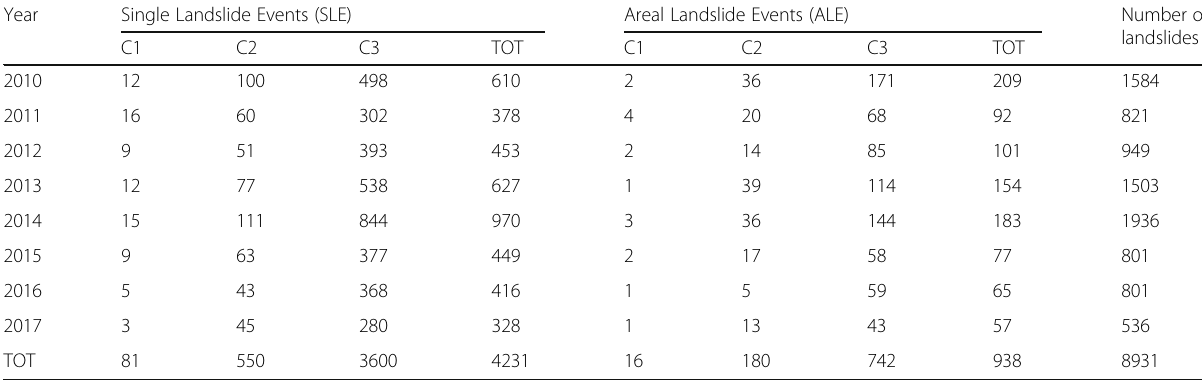
Table 2 Landslides inventoried in the “ FraneItalia ” catalog from 2010 to 2017